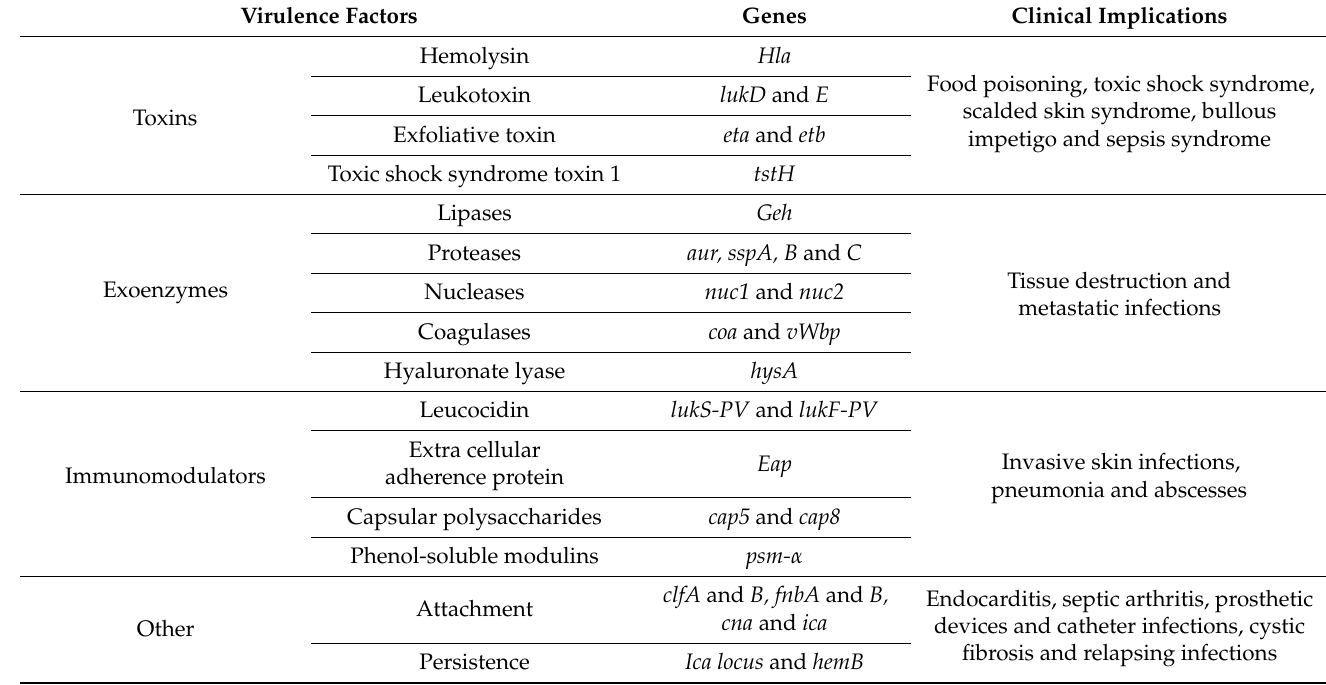
Table 1. A list of different virulence factors, their corresponding regulatory genes and their resultant clinical implications. Data have been collected from Otto (2014), Gordon (2008) and Oogai (2011)